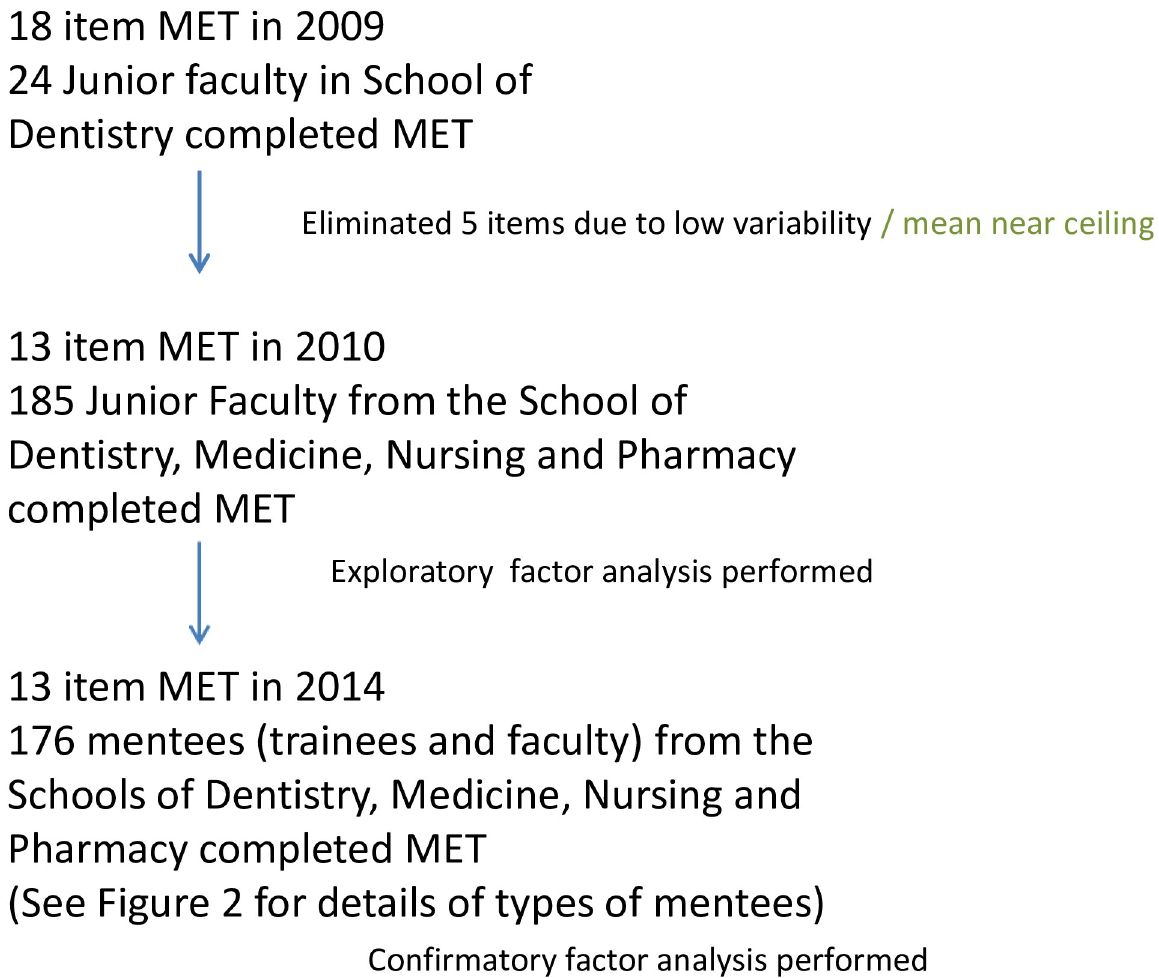
Fig 1. Mentor Evaluation Tool